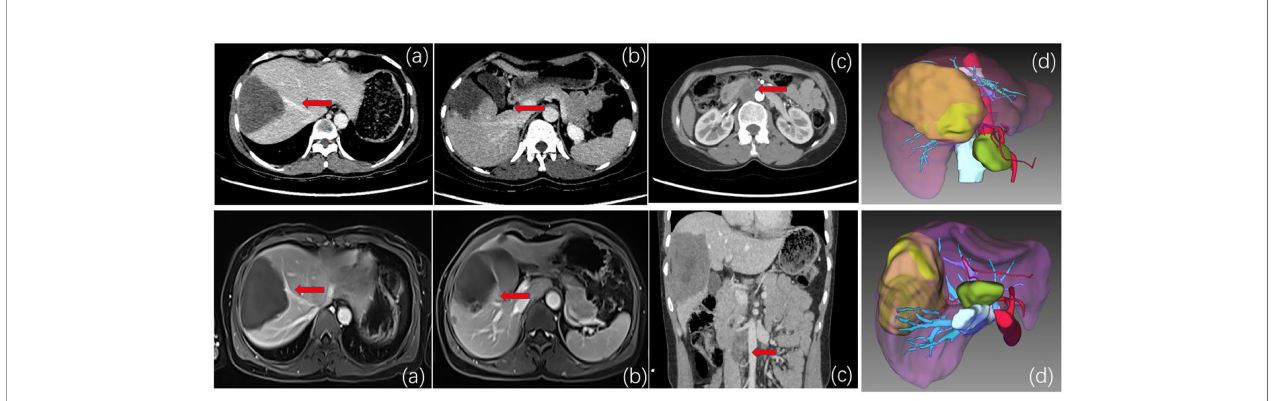
FIGURE 1 | (A) CT and MRI venous phase. The red arrow indicates that the middle hepatic vein is close to the lesion and is considered to be invaded. (B) CT and MRI delayed phase. The red arrow indicates that the right anterior branch of the portal vein is considered to be invaded. (C) CT and MRI. The red arrow indicates inferior vena cava-para-abdominal aortic swelling. Large lymph nodes are approximately 2*2 cm in diameter. The lesions are low signal, and no enhancement is seen after enhancement. Thus, lymph node metastasis of alveolar echinococcosis was considered. (D) Preoperative three-dimensional CT and imaging showed enlarged lymph nodes in the inferior vena cava-abdominal aorta. Considered secondary lymph node metastasis of alveolar echinococcosis.